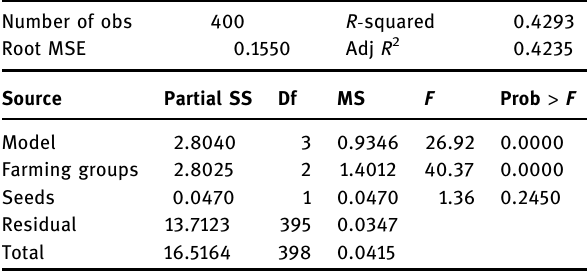
Table 4: Two - way ANOVA of harvest output di ff erences among farming groups and seeds planted Number of